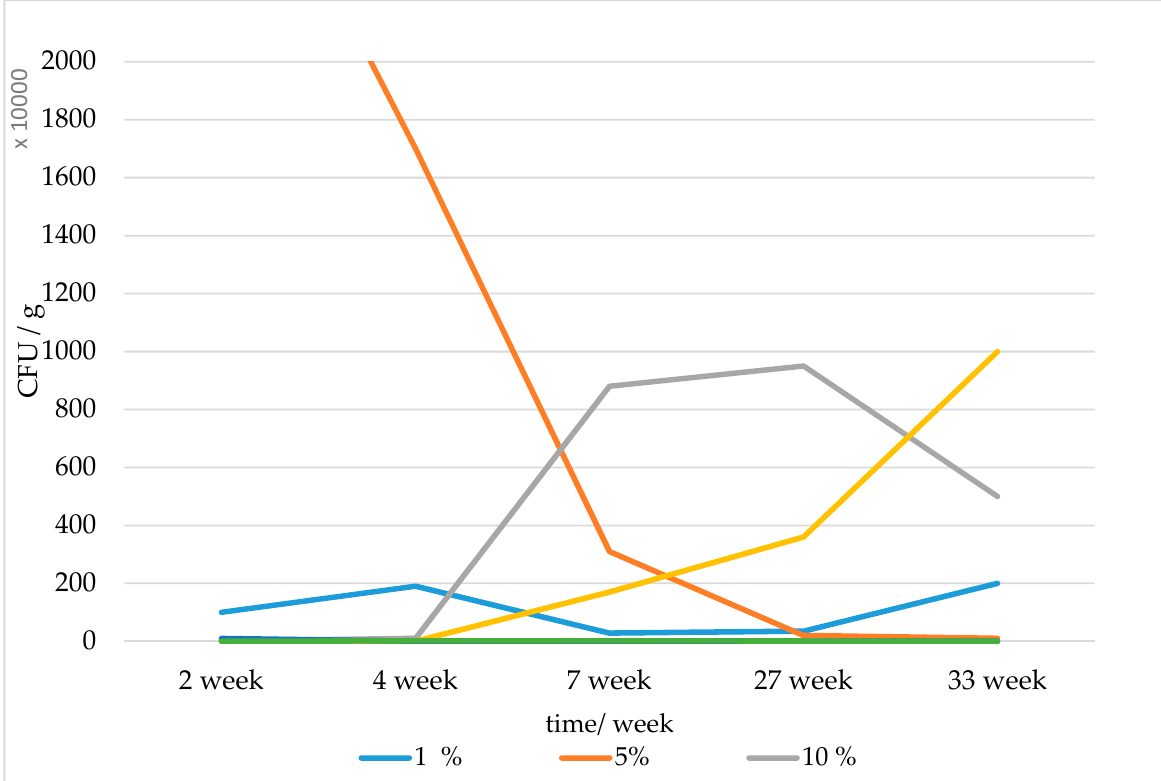
Figure 1. Dynamics of the number of lipolytic